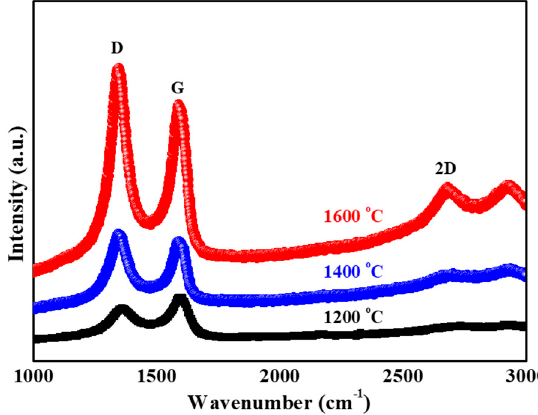
Figure 2. The Raman spectra of as-prepared composites after di ff erent pyrolysis temperatures.